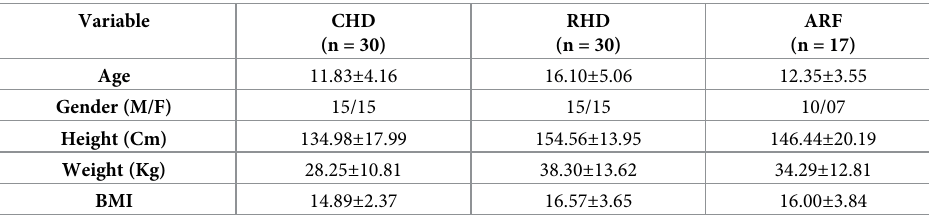
Table 1. Demographic profile of the study population *